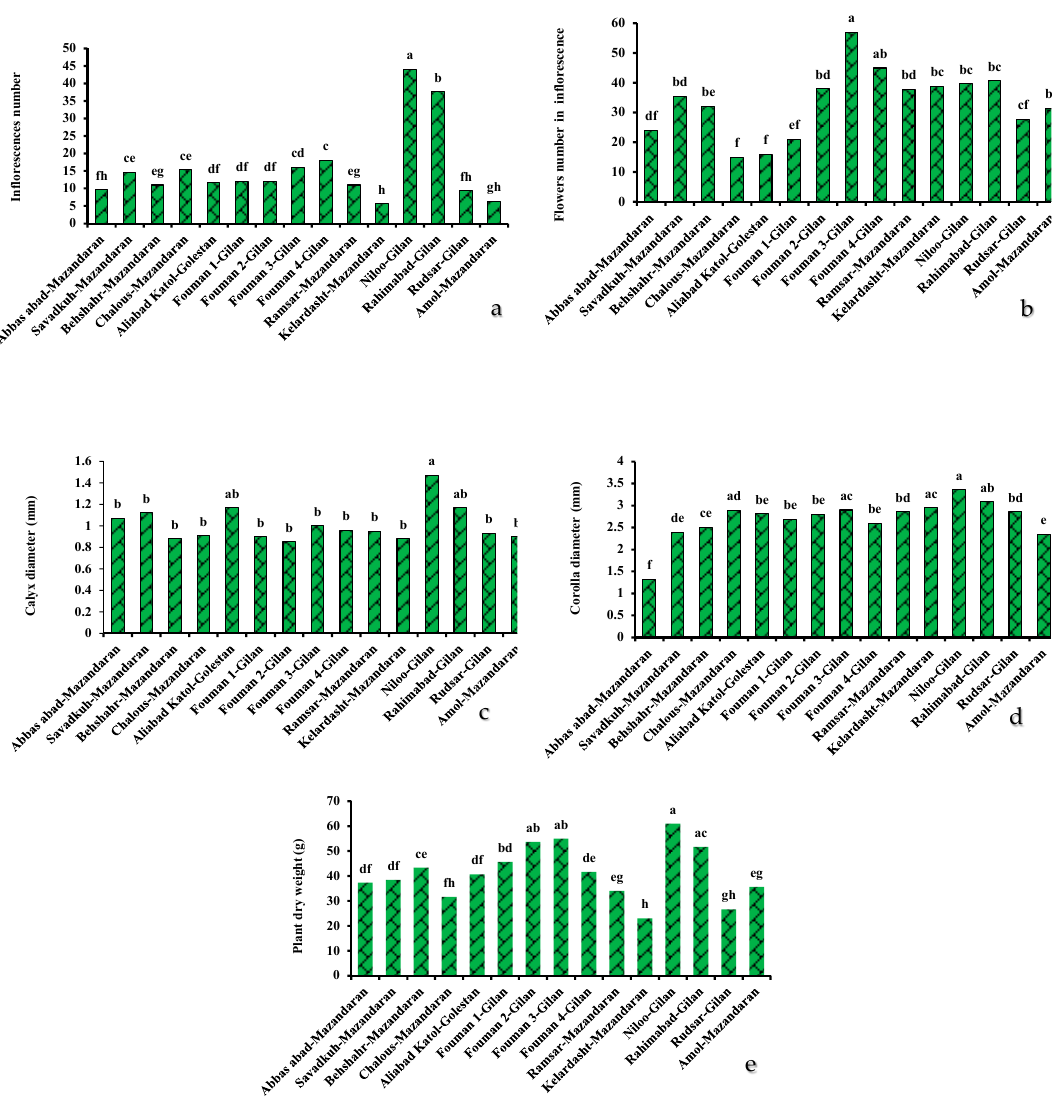
Figure 5. Mean comparison for inflorescence number ( a ), flower number in inflorescence ( b ), corolla diameter ( c ), calyx length ( d ), and plant dry weight ( e ) in different ecotypes of M. aquatica collected from the Hyrcanain hotspot of Iran. Different letters indicate significant differences according to the LSD test at p < 0.05.